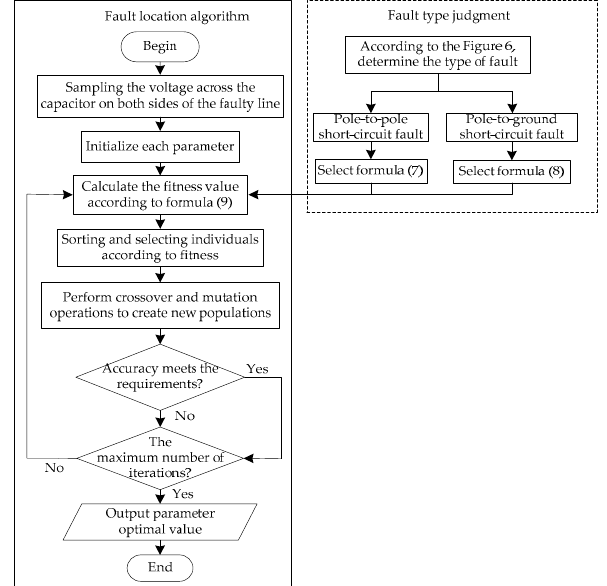
Figure 7. Algorithm flowchart.